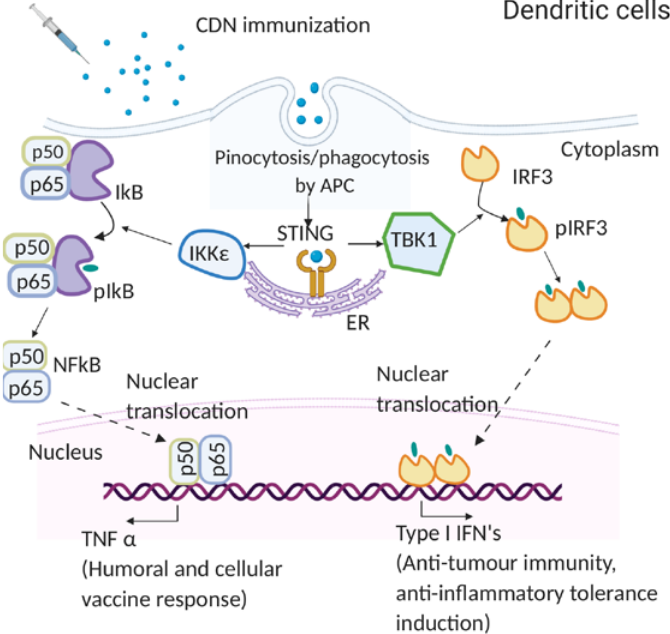
Figure 1. The mode of action of cyclic dinucleotides (CDNs) in dendritic cells (DCs). Immunized CDNs are taken up by pinocytosis or phagocytosis by dendritic cells in vivo. In the cytoplasm, CDNs bind to STING dimers located on the endoplasmic reticulum (ER) membrane, which undergoes conformational changes and activation. The STING (Stimulator of interferon genes) activation recruits kinases TANK binding kinase 1 (TBK 1) or IκB kinase (Iκκε). TBK 1 phosphorylates interferon regulatory factor 3 (IRF3), which dimerizes and translocates to the nucleus to activate type I IFNs. Iκκε phosphorylates nuclear factor- κB (NF - κB) inhibitor IκBα leading to dissociation of IκBα from NF- κB and translocation of the later to the nucleus to activate pro-inflammatory cytokines such as TNF- α.